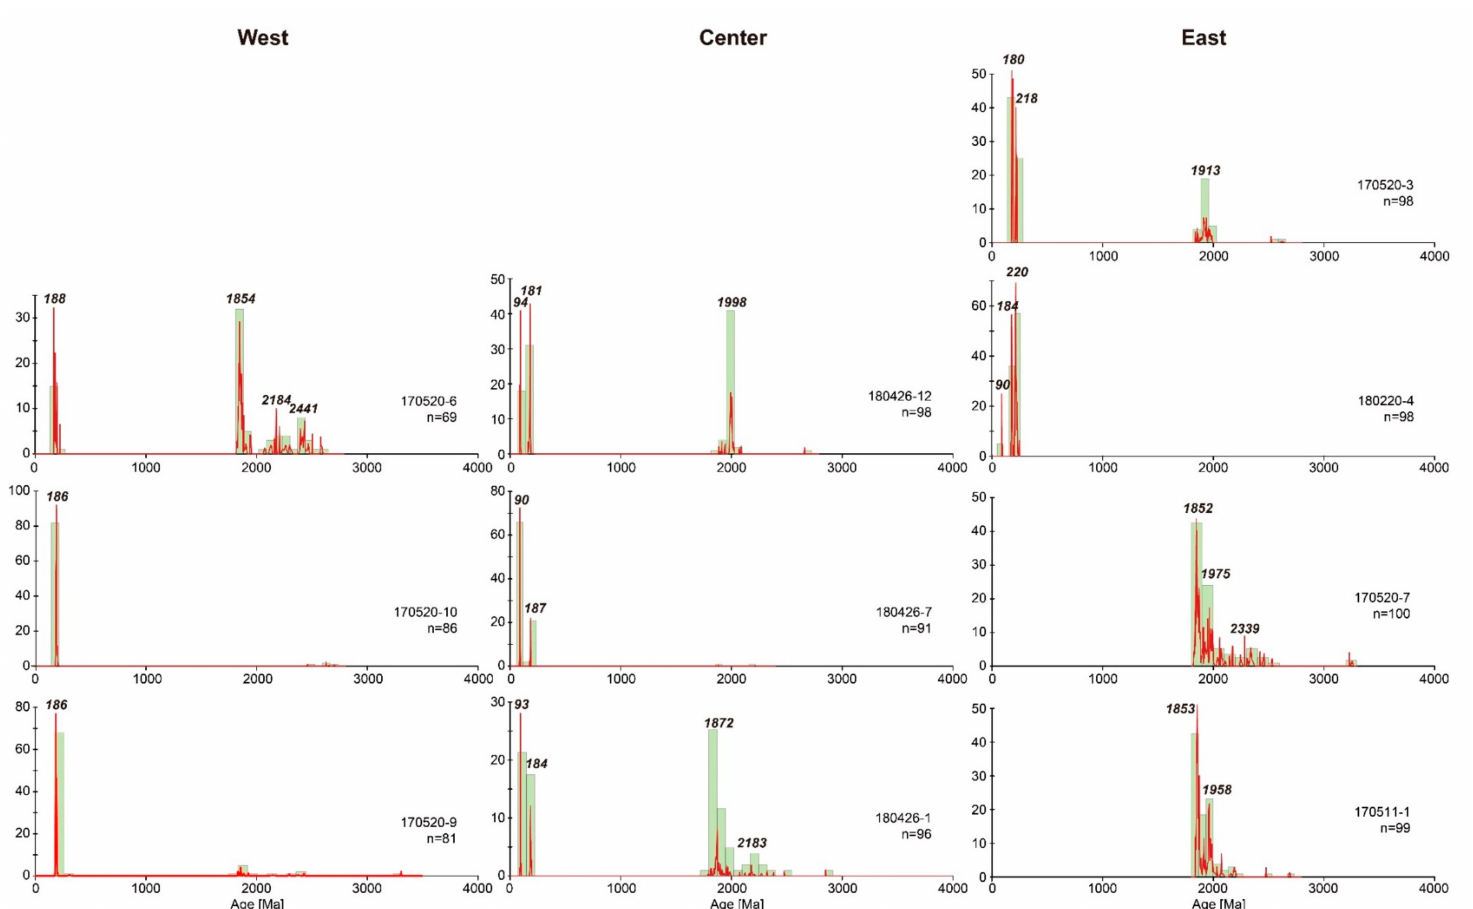
Figure 5. Probability density plots [39] of the detrital zircon grains in the conglomerate and sandstone samples in the Neungju Basin. 206 Pb / 238 U ages for < 1000 Ma and 207 Pb / 206 Pb ages for > 1000 Ma were used for age probability curves, with a discordance of < ± 10%. The plots show di ff erences in their age population according to the sample location. Note that only the age spectra of the central samples and one eastern sample (180220-4) include Cretaceous